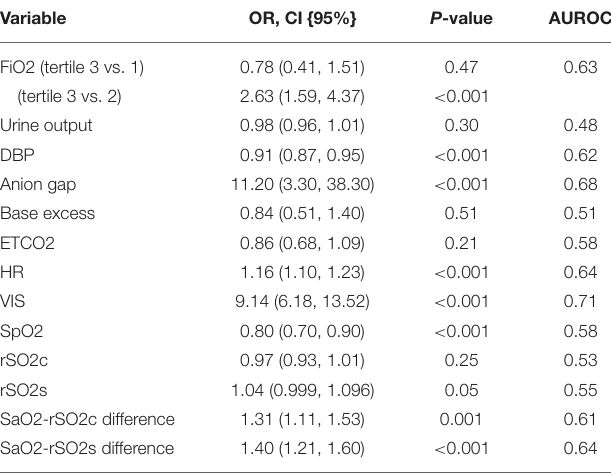
TABLE 4 | Univariate predictors of cardiac arrest.